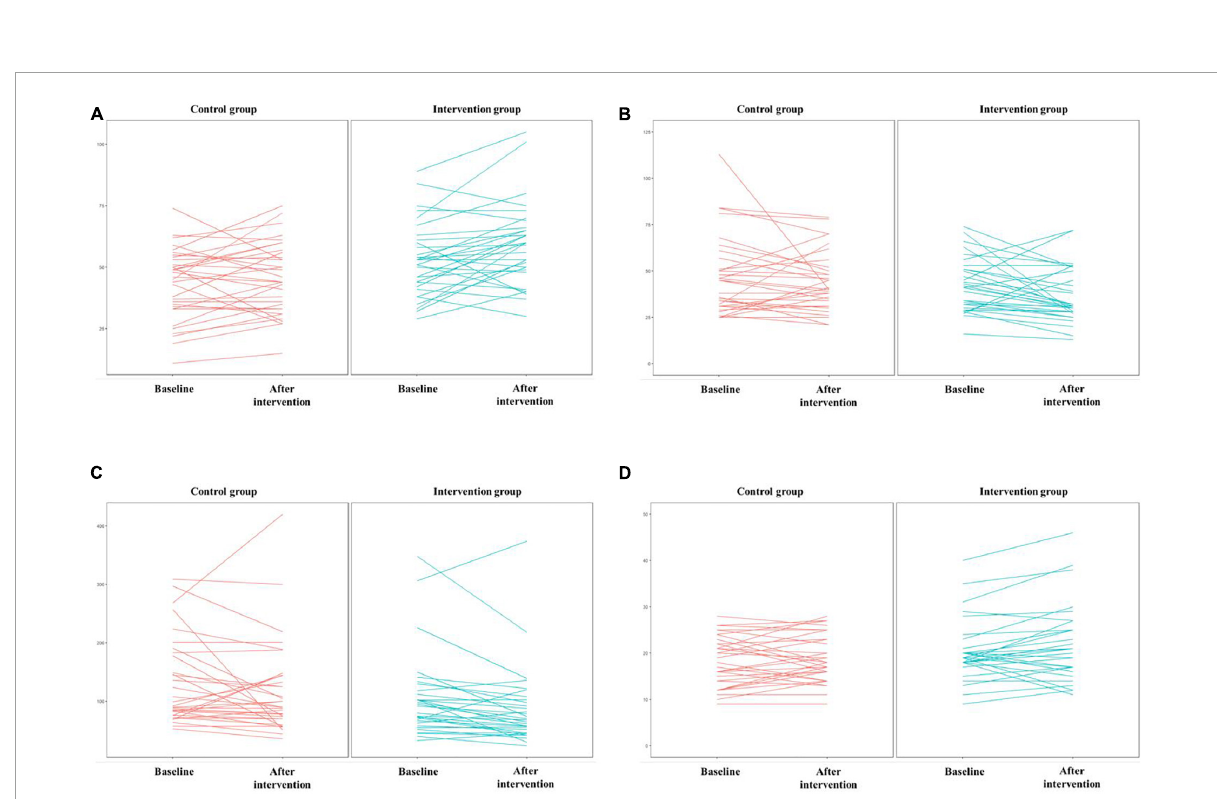
FIGURE6 Scores on the four Brief Cognitive Assessment Tool for Schizophrenia (B-CATS) tests. (A) DSST, (B) TMTA, (C) TMTB, (D)